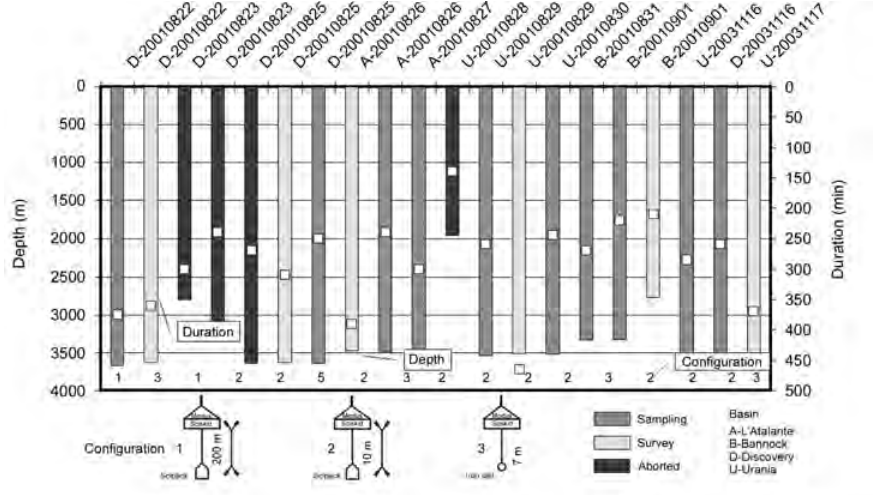
Fig. 5. Summary of the operations during cruise I and II of BIODEEP in the four DHABs (D – Discovery; A – L’Atalante; U – Urania; B – Bannock): type of operation and configuration (colour code and number code in the legenda), operation depth and duration (length of the blocks and white